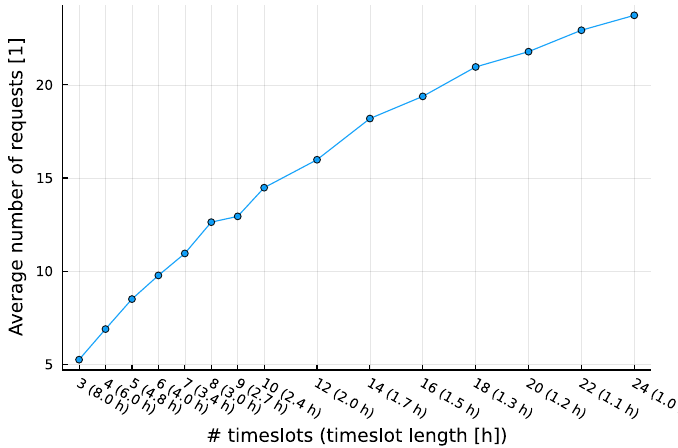
Figure 4. The number of requests in the experiment with constant expected duration of all charging requests, but a varying number of